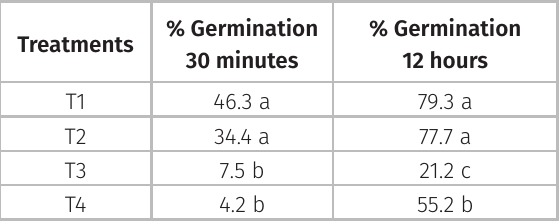
Table V. Germination of H. polyrhizus (red-fleshed pitaya) pollen grains of evaluated 30 minutes and 12 hours after inoculation in culture medium. T1 = 7 p.m., without cup cover; T2 = 7 p.m., with cup cover; T3 =